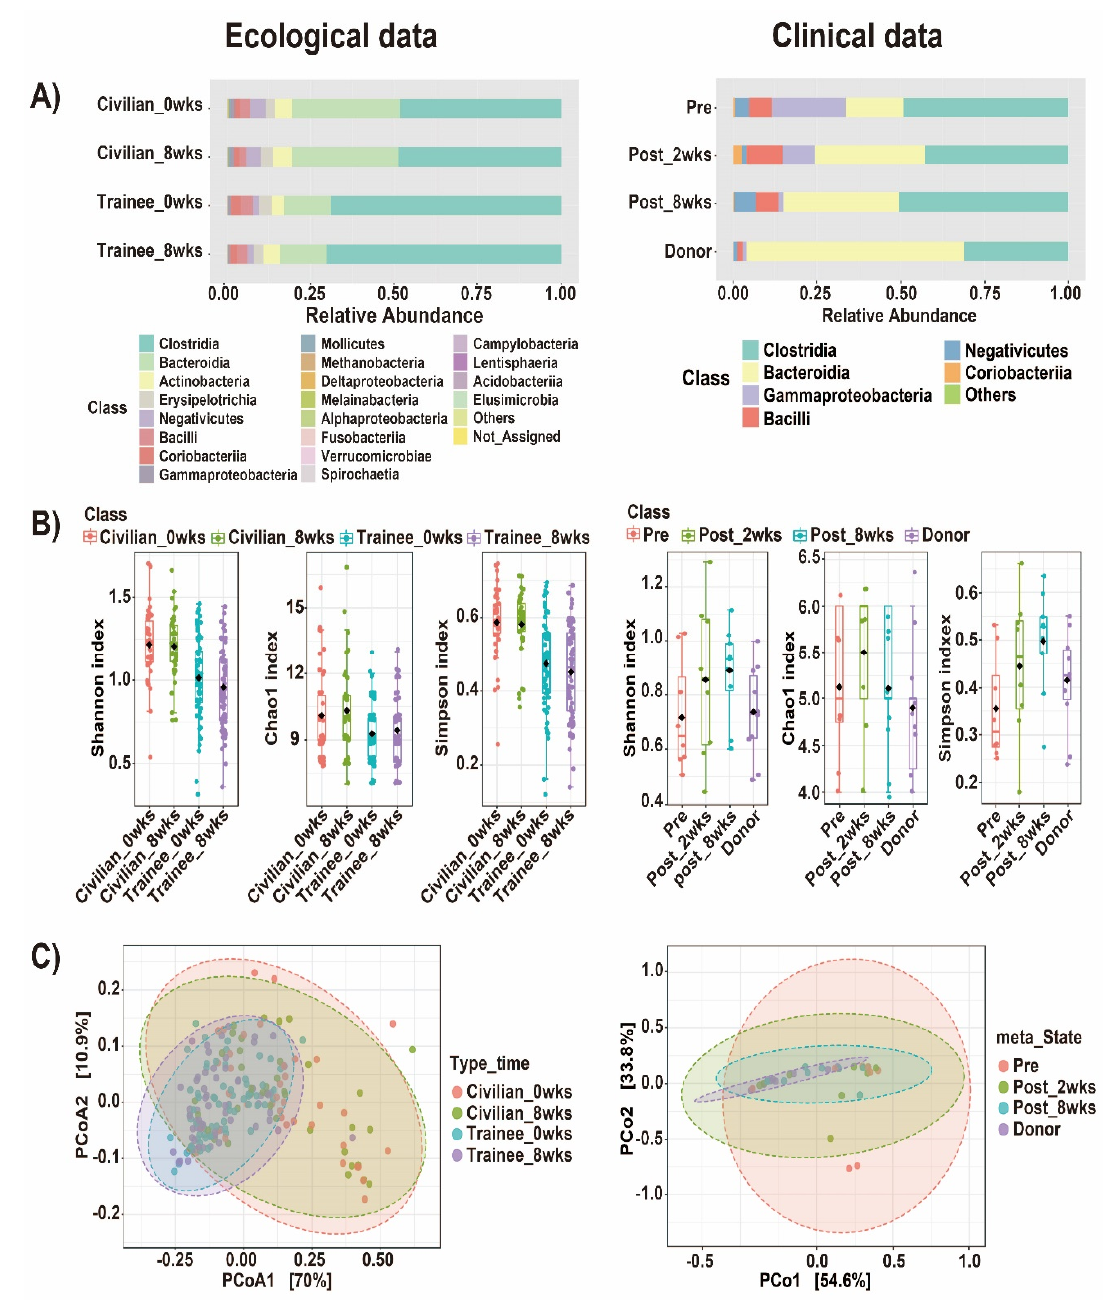
Figure 2. Output figures for ( A ) taxonomic data (class), ( B ), alpha diversity (Shannon, Chao1, and Simpson index), and ( C ) beta diversity (Bray − Curtis dissimilarity) based on different analysis approaches using ecological (left) and clinical (right) datasets in MicrobiomeAnalyst.